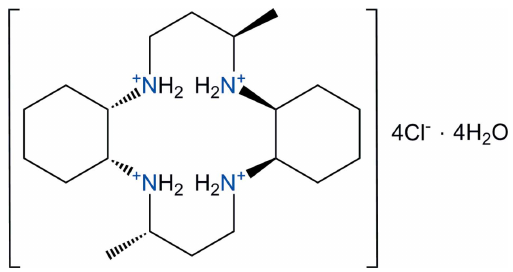
Figure 1 The molecular structure of compound (I), drawn with displacement ellipsoids at the 50% probability level. Dashed lines represent hydrogen- bonding interactions and primed atoms are related by the symmetry code (1 (cid:3) x , 1 (cid:3) y , 1 (cid:3) z ).